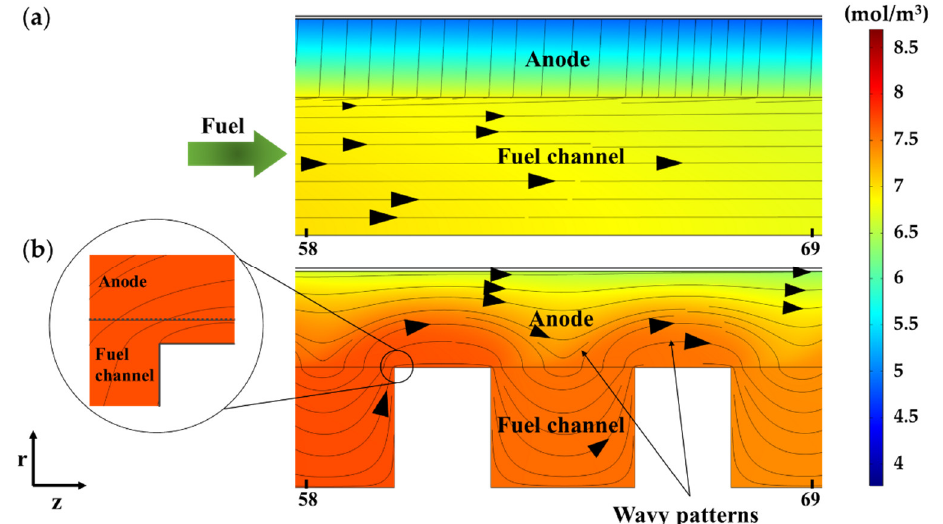
Figure 4. The predicted streamlines and H 2 molar concentrations in the fuel channels and anodes of tubular SOFCs with ( a ) no insert and ( b ) a convergent conical ring insert (the offset angle is 0 de- grees).